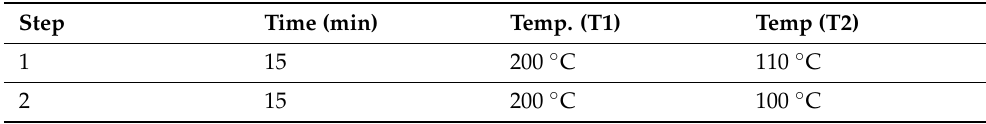
Table 3. Setting for acid digestion for the microwave oven digestor (Milestone START D, Model: